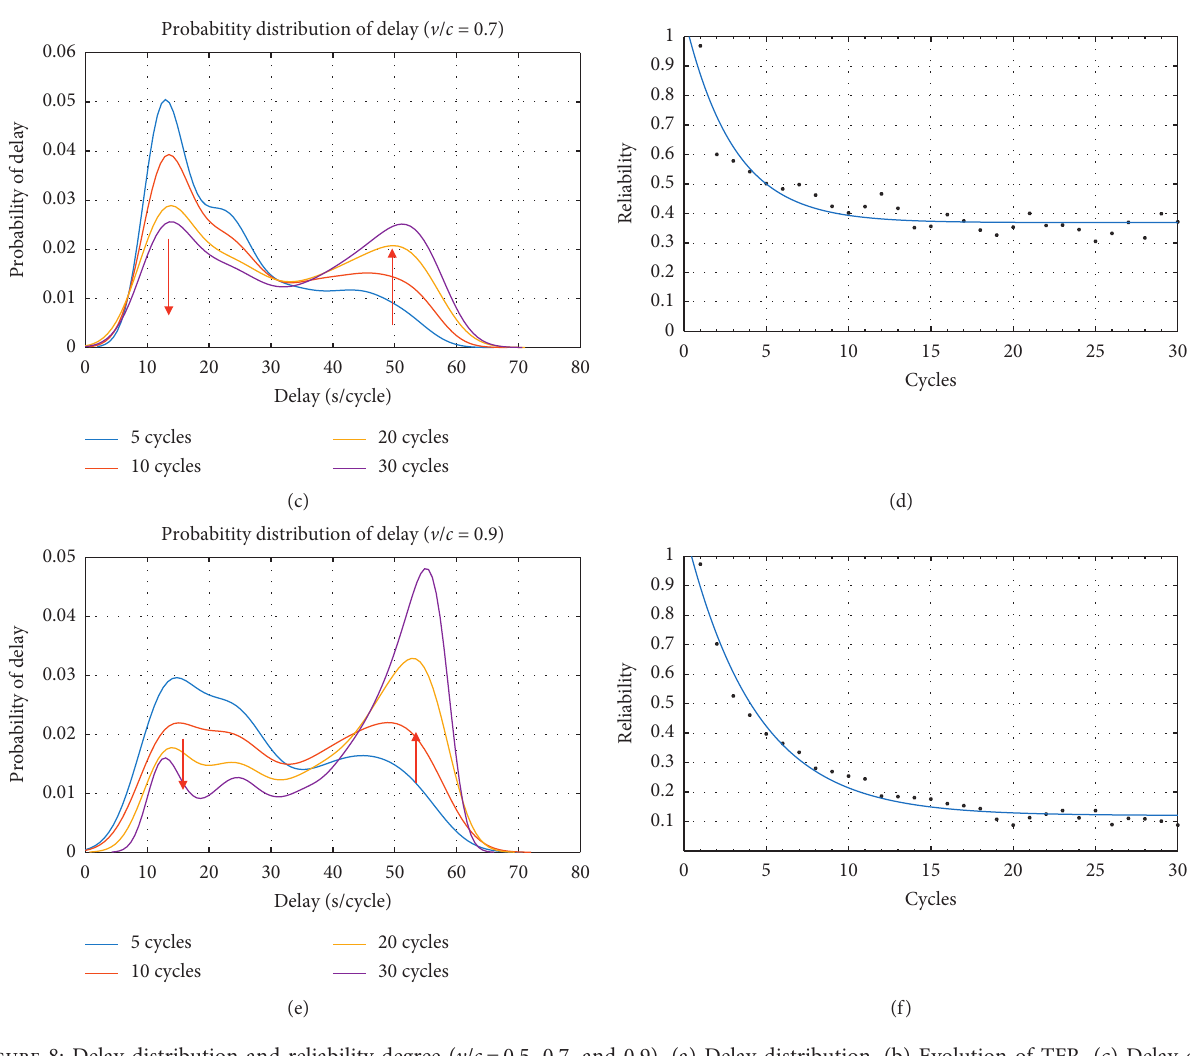
Figure 8: Delay distribution and reliability degree ( v / c � 0.5, 0.7, and 0.9). (a) Delay distribution. (b) Evolution of TFR. (c) Delay dis- tribution. (d) Evolution of TFR. (e) Delay distribution. (f) Evolution of